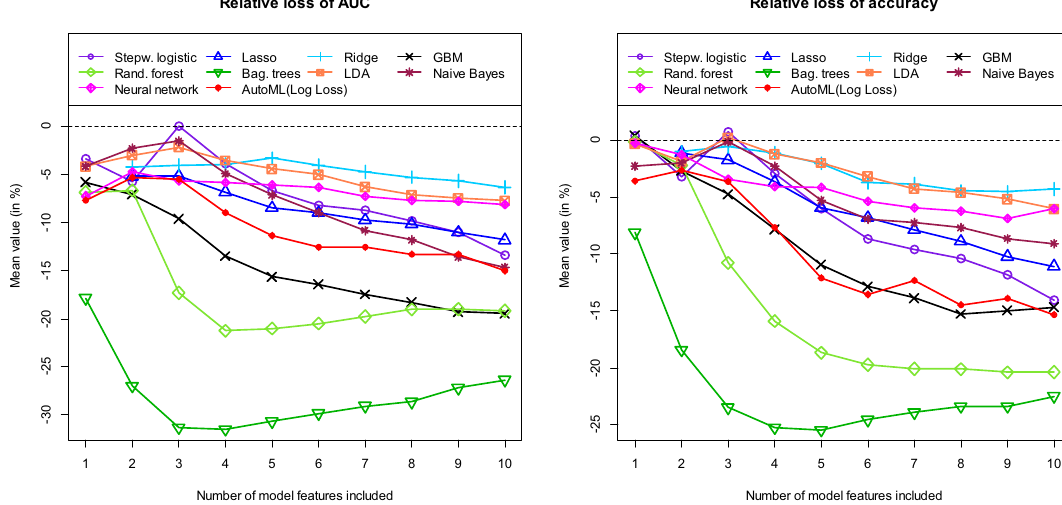
Figure 7. Relative Loss of Performance (RLP) for AutoML (red lines), neural network (pink lines) and conventional machine learning models (other lines). Left figure: AUC. Right figure: accuracy. All values calculated as means of 100 repetitions (100 cycles).